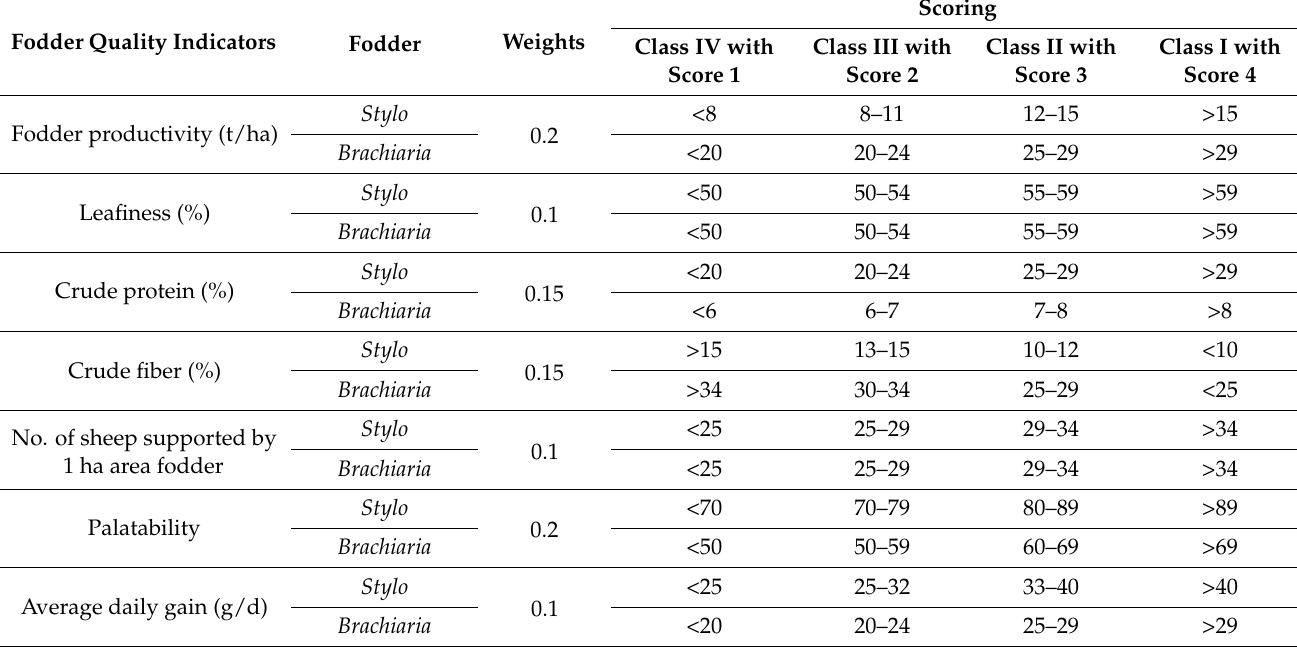
Table 3. The framework of fodder quality indicators and their weights along with